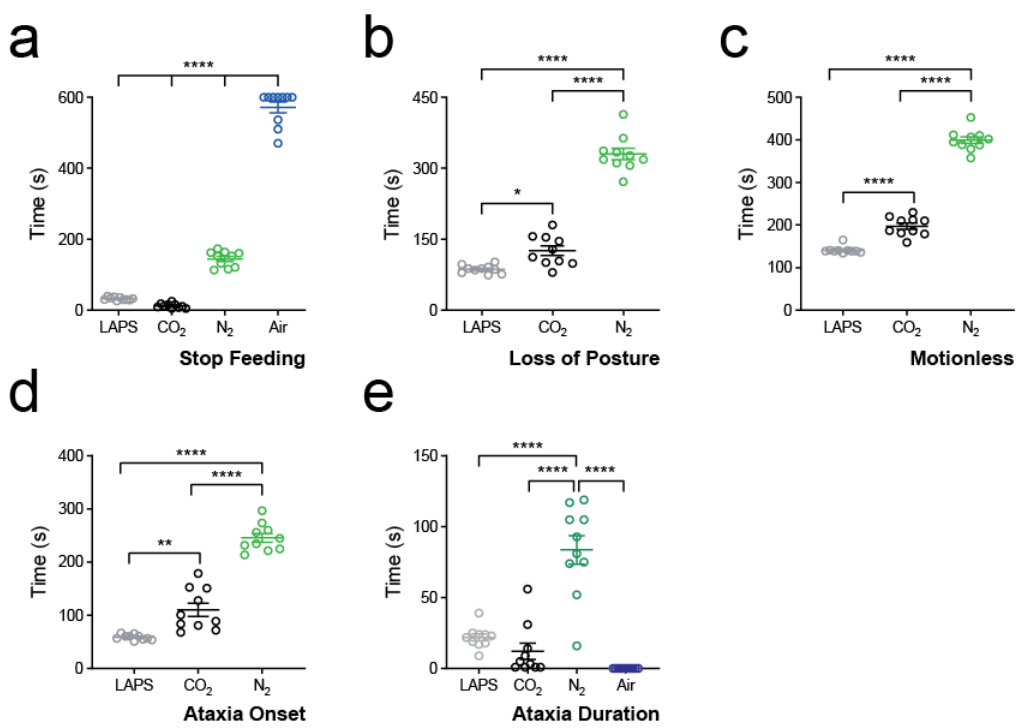
Figure 3. Timing of primary outcomes. ( a ) Raw data, mean ± standard error mean (s.e.m.), of time to stop feeding for all treatment groups. **** p < 0.0001; one-way ANOVA. ( b ) Raw data, mean ± s.e.m., of time to loss of posture (LOP) for LAPS (grey), CO 2 (black) and N 2 (green) treatment groups. * p < 0.05, **** p < 0.0001; one-way ANOVA. Note that LOP was not observed in any bird in the medical air group. ( c ) Raw data, mean ± s.e.m., of time to motionless for LAPS (grey), CO 2 (black) and N 2 (green) treatment groups. **** p < 0.0001; one-way ANOVA. Note that motionlessness was not observed in any bird in the air group. ( d ) Raw data, mean ± s.e.m. of time to onset of ataxia for LAPS (grey), CO 2 (black) and N 2 (green) treatment groups. Note that no ataxia was observed in any bird in the air group. ** p < 0.01, **** p < 0.0001; one-way ANOVA. ( e ) Raw data, mean ± s.e.m. of ataxia duration for all treatment groups. **** p < 0.0001.